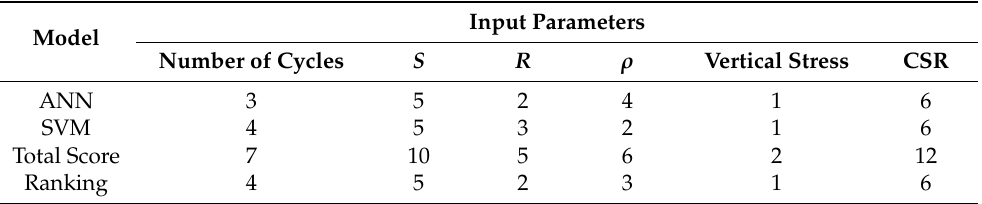
Table 9. Ranking results of variable importance for the proposed ANN and SVM models.